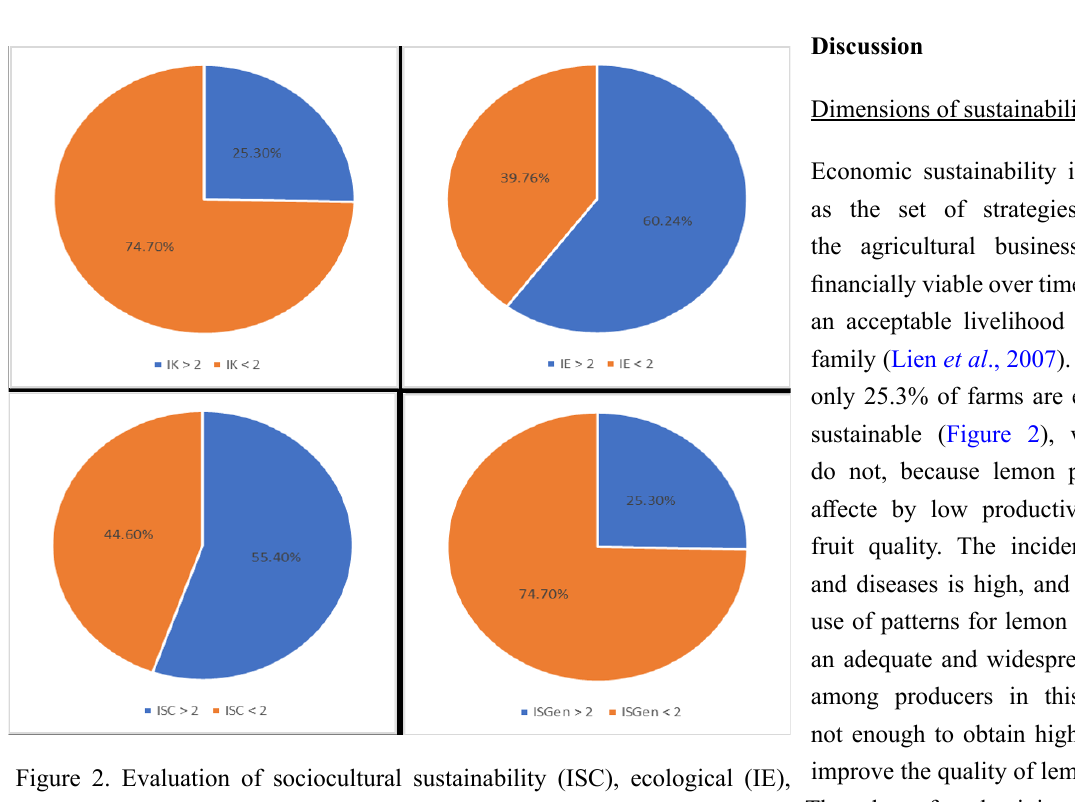
Figure 2. Evaluation of sociocultural sustainability (ISC), ecological (IE), economic (IK) and General Sustainability Index (ISG) of lemon producing farms, in Santa Elena,